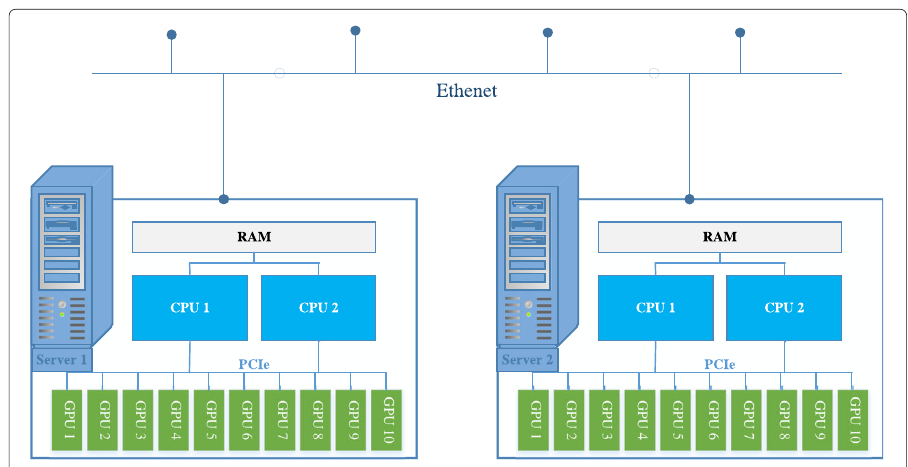
Fig. 1 Framework of modern GPU cluster. The computational nodes are connected with high speed networks. GPUs deliver the majority of performance of modern GPU